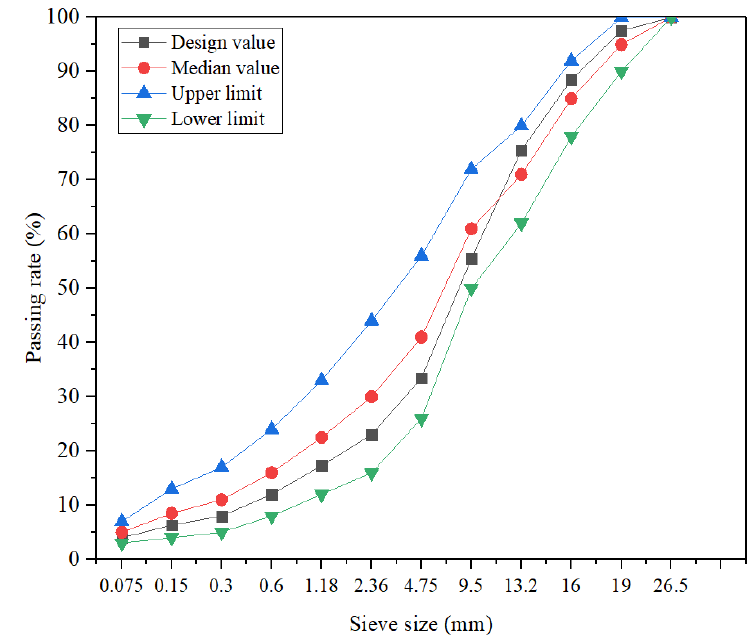
Figure 3. Gradation of AC-20.